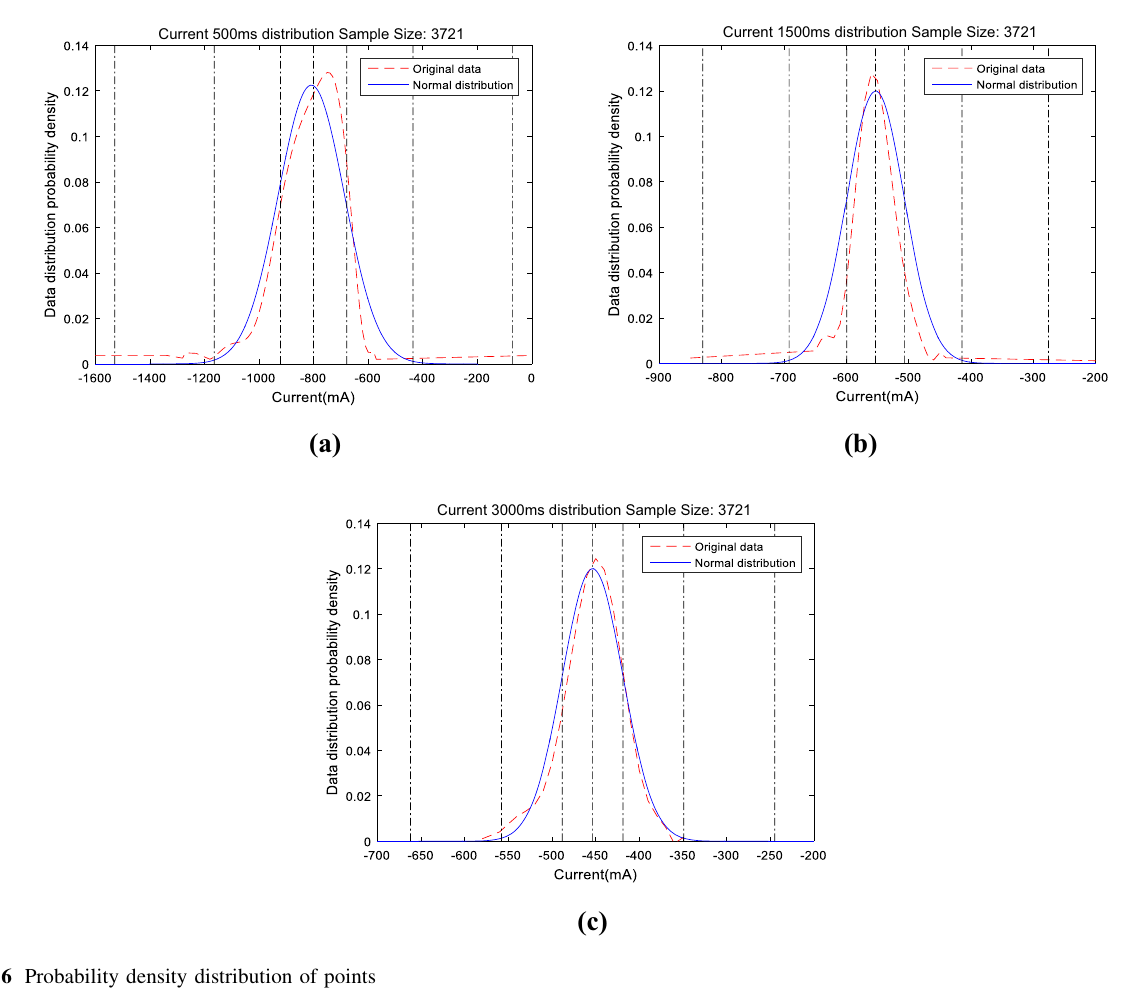
Fig. 6 Probability density distribution of